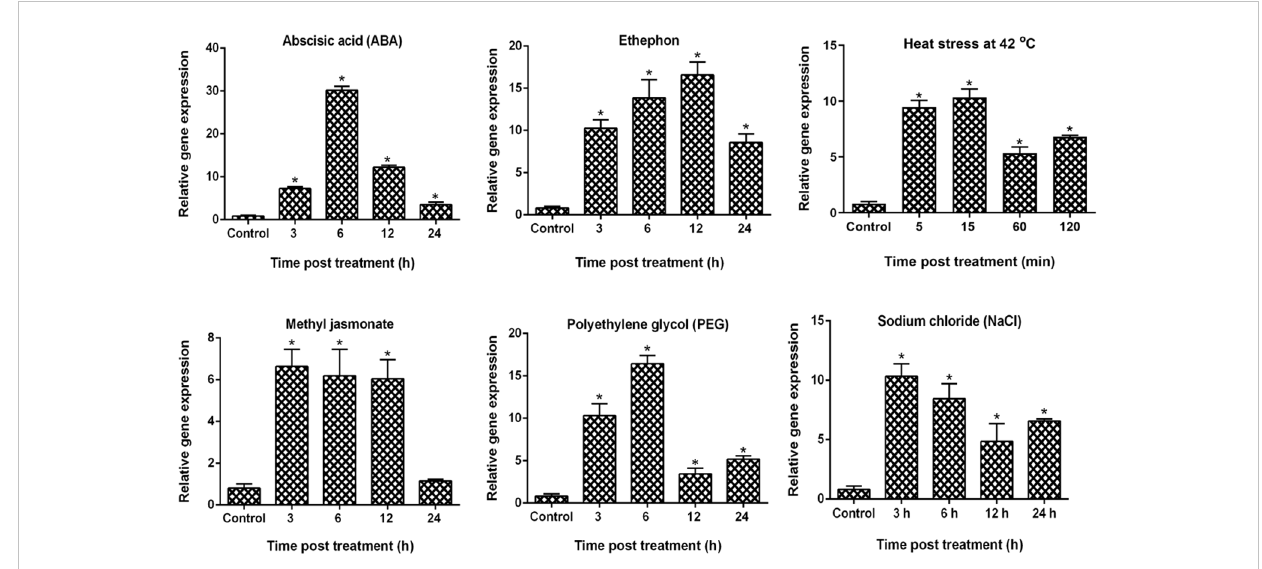
FIGURE 1 Relative expression analysis of VaDJI gene in V. aconitifolia by using qRT-PCR in response to various hormonal and abiotic stresses. Seedling samples collected at various time points were treated with PEG, heat stress, ABA, NaCl, ethephon and methyl jasmonate. Mean values of the fold change values of three biological and technical replicates for the expression study were used in the qRT-PCR analysis. Livak ’ s DD C T method was used to calculate the expression level. The experiment here included three biological and three technical repeats. Values are mean ± SE (* at p ≤ 0.05